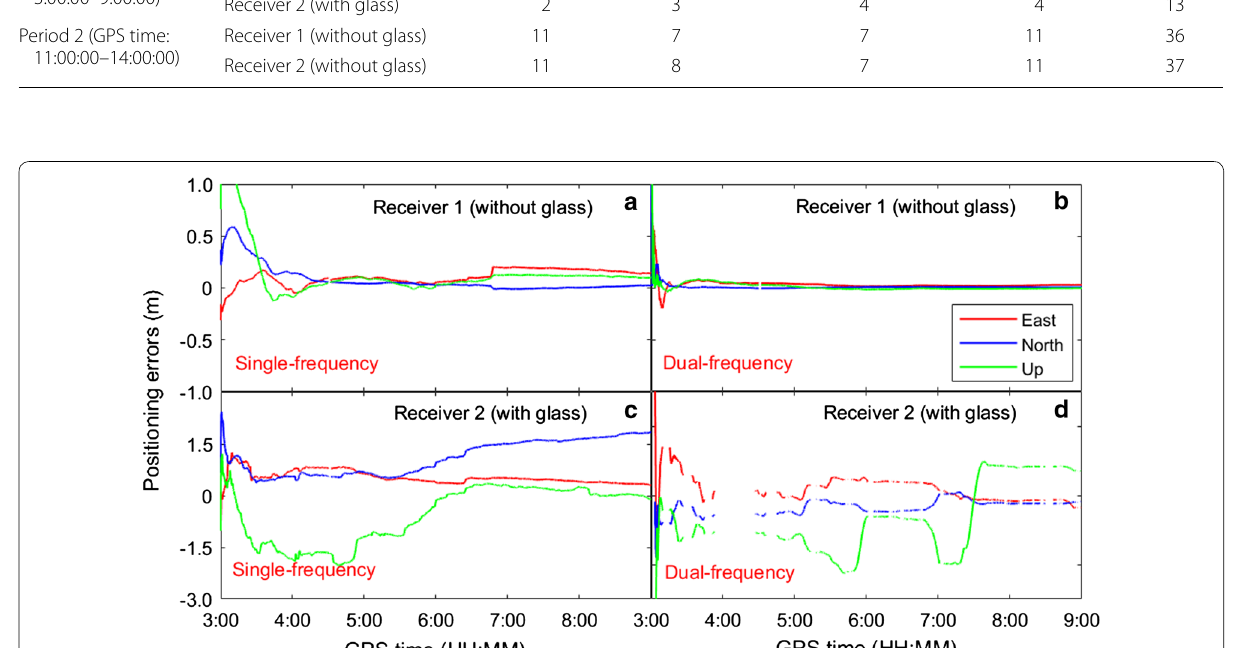
Fig. 6 GPS/GLONASS single- and dual-frequency static positioning results for the two receivers during period 1